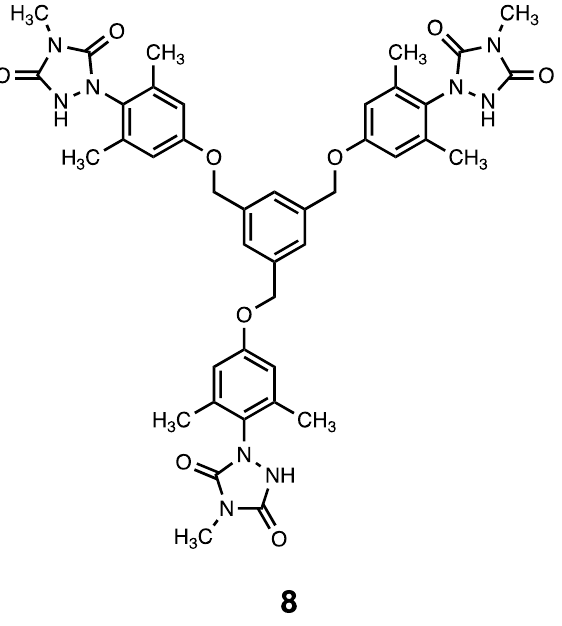
Figure 1. Structure of target triurazole, 8 .